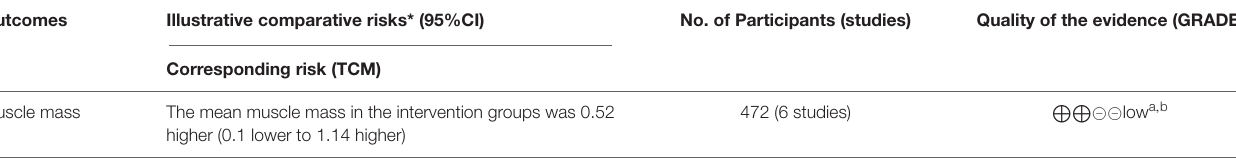
TABLE 6 | Muscle mass for sarcopenia.